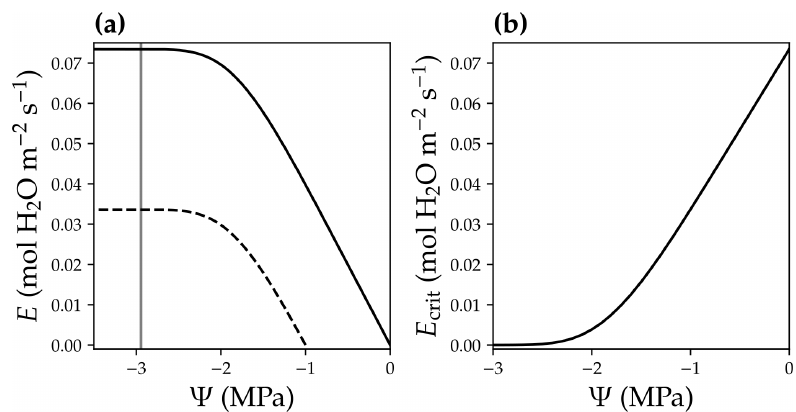
Figure 5. Leaf critical flow rate changes with leaf base xylem pressure. (a) Leaf xylem water supply curves at two different leaf base xylem pressures ( (cid:57) base ; black solid curve for a (cid:57) base = 0MPa, and black dashed curve for a (cid:57) base = − 1MPa). A xylem water supply curve is the plot of the leaf xylem flow rate ( E ) vs. leaf xylem end pressure ( (cid:57) ) at a given (cid:57) base ( (cid:57) = (cid:57) base when E = 0). The gray vertical line plots the xylem pressure at which leaf xylem conductance reaches 0.1% of the maximum. The intersection of the gray line and the xylem water supply curve indicates the critical xylem flow rate ( E crit ). (b) E crit decreases with more negative (cid:57) base